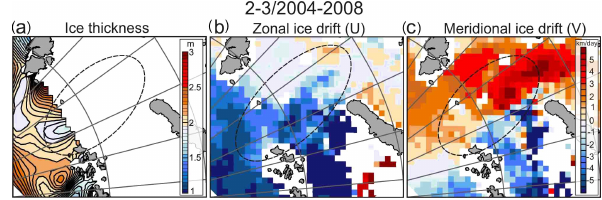
Figure 11. The 2004–2008 winter mean (February–March) (a) sea ice thickness (m) and (b) zonal and (c) meridional sea ice drift (km day − 1 ) derived from AMSR data. The dashed oval highlights the ST region.